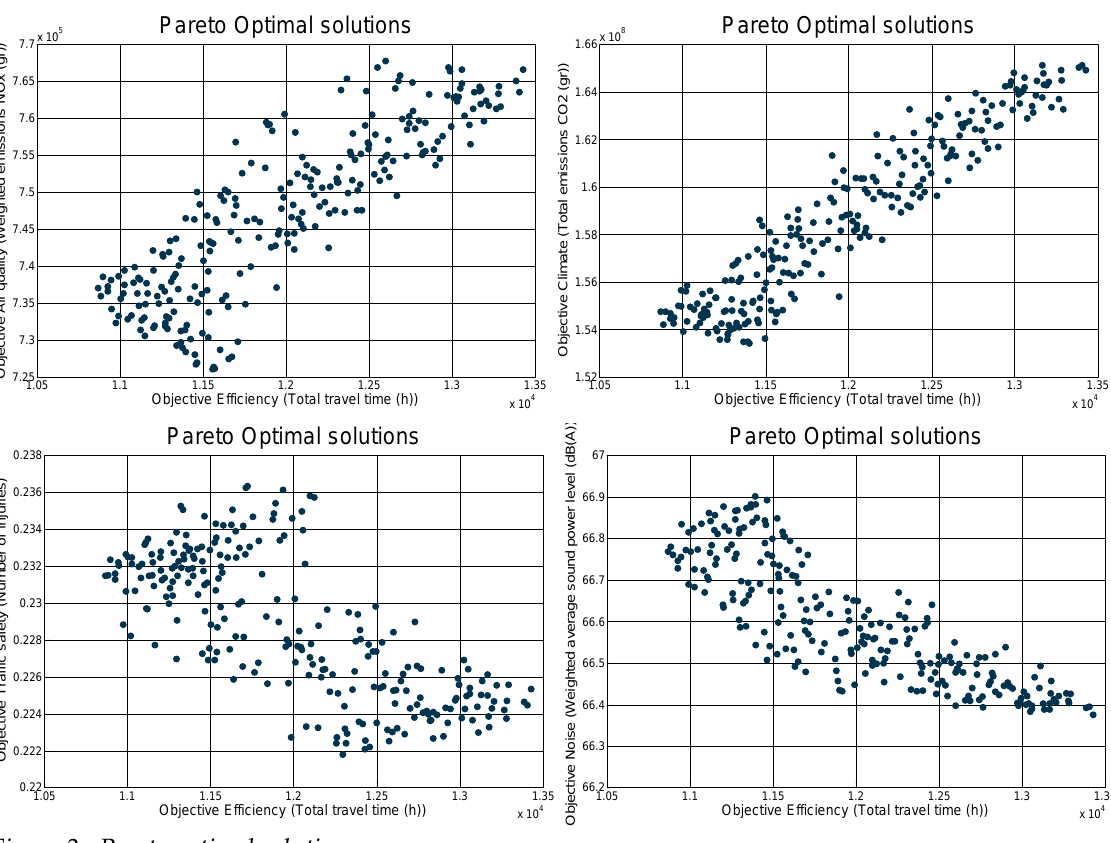
Figure 2. Pareto optimal